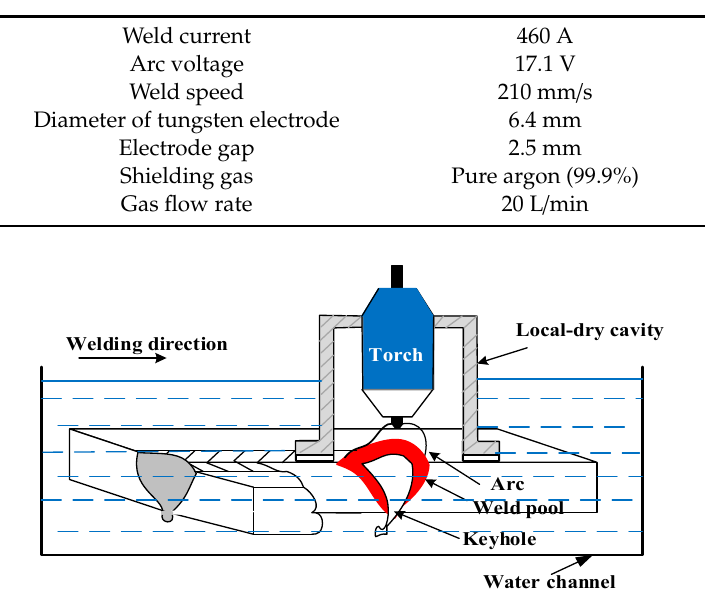
Figure 1. The underwater local-dry (UL) K-TIG welding equipment.